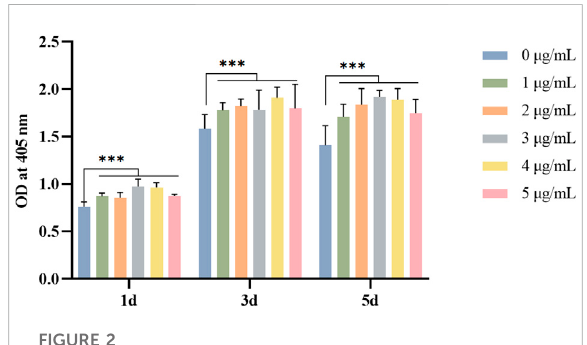
FIGURE 2 Effect of DP with different concentration on fi